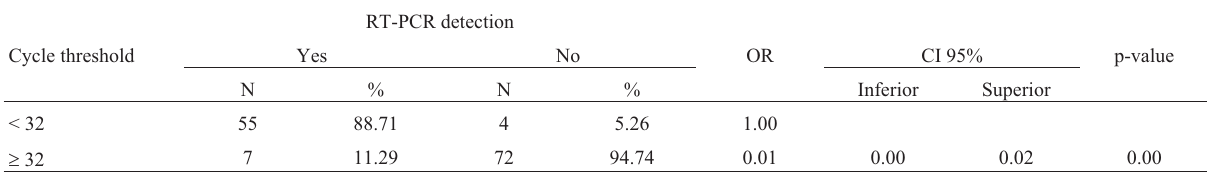
Table 1 - Detection limits of the RT-PCR technique using mosquito positive samples artificially blood-fed with Zika virus and previously screened by RT-qPCR. RT-PCR